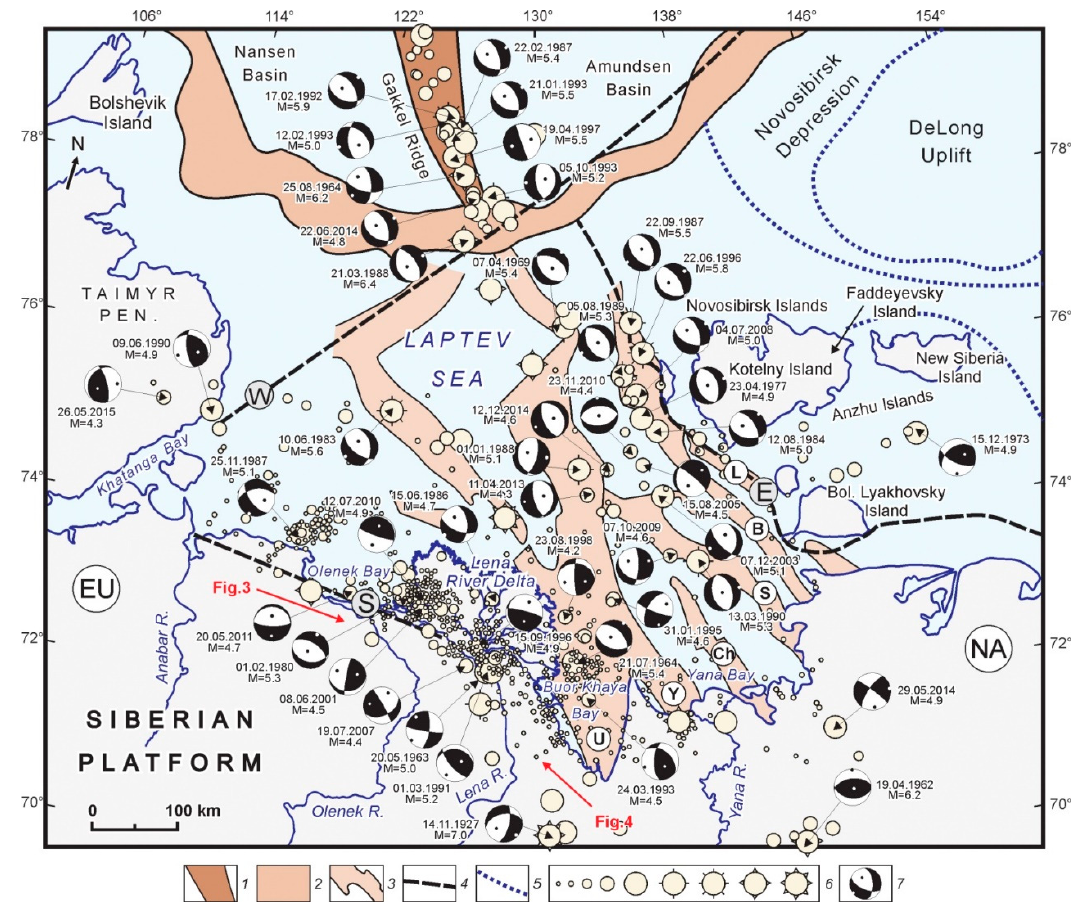
Figure 2. Seismotectonics of the Laptev Sea segment (modified after [7]). 1—Gakkel spreading